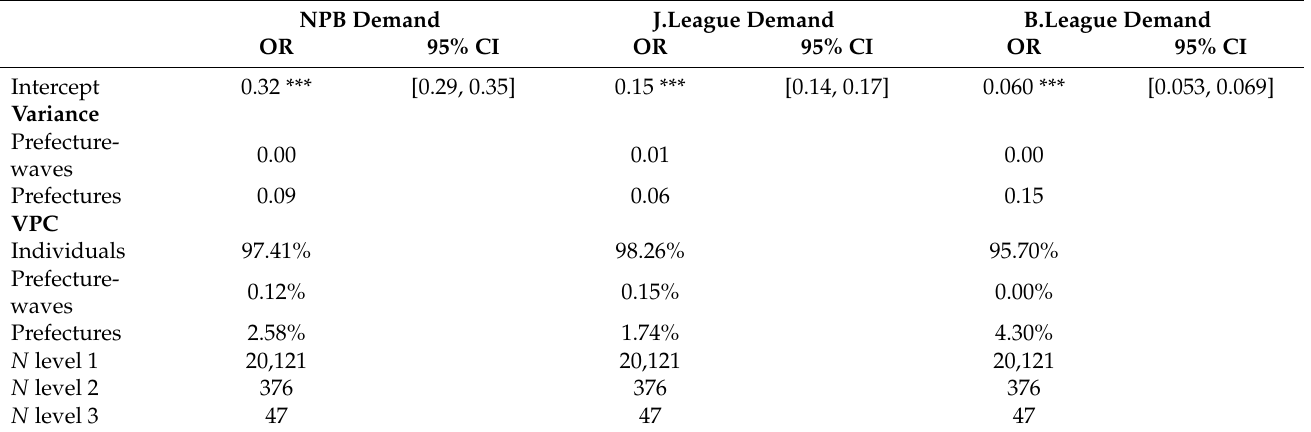
Table 3. Results of multilevel logistic regression (intercept-only model) on spectator demand of Japanese citizens during the COVID-19